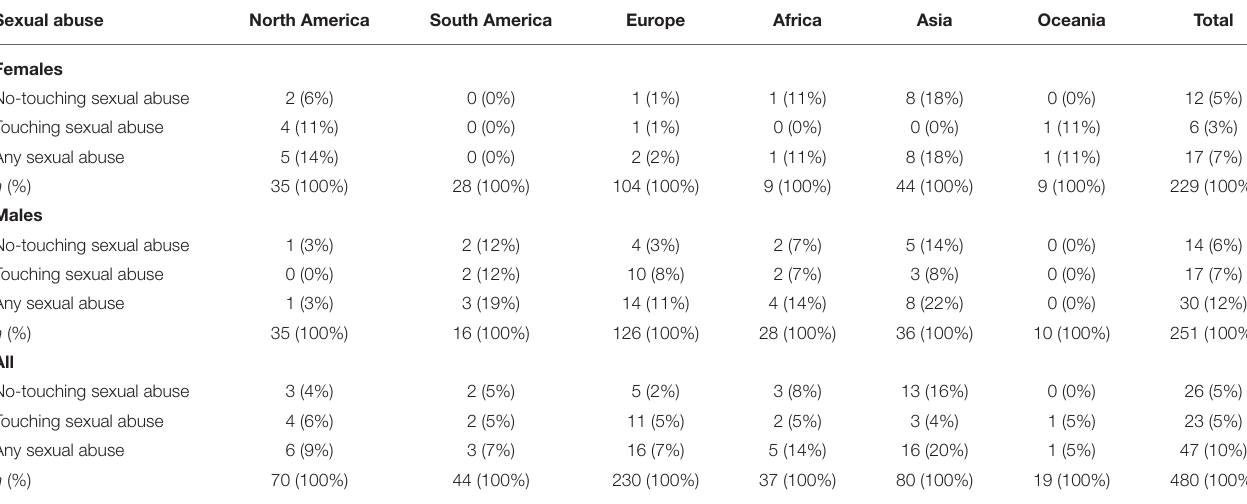
TABLE 8 | Lifetime sexual abuse experiences inside Athletics displayed by global geographical